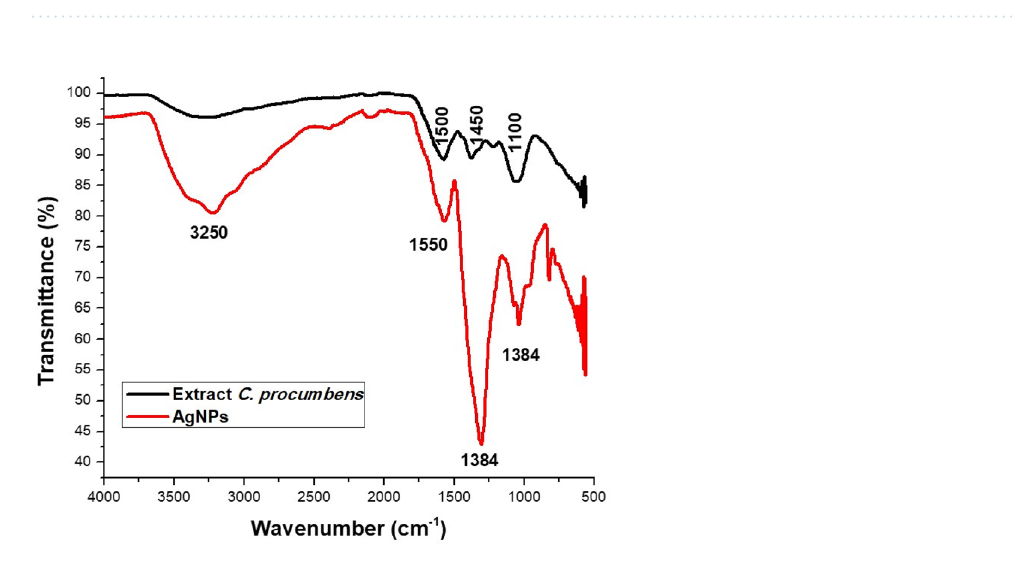
Figure 1. UV–vis absorption kinetic spectra of C. procumbens synthesized silver nanoparticles every 20 min for 6 h.